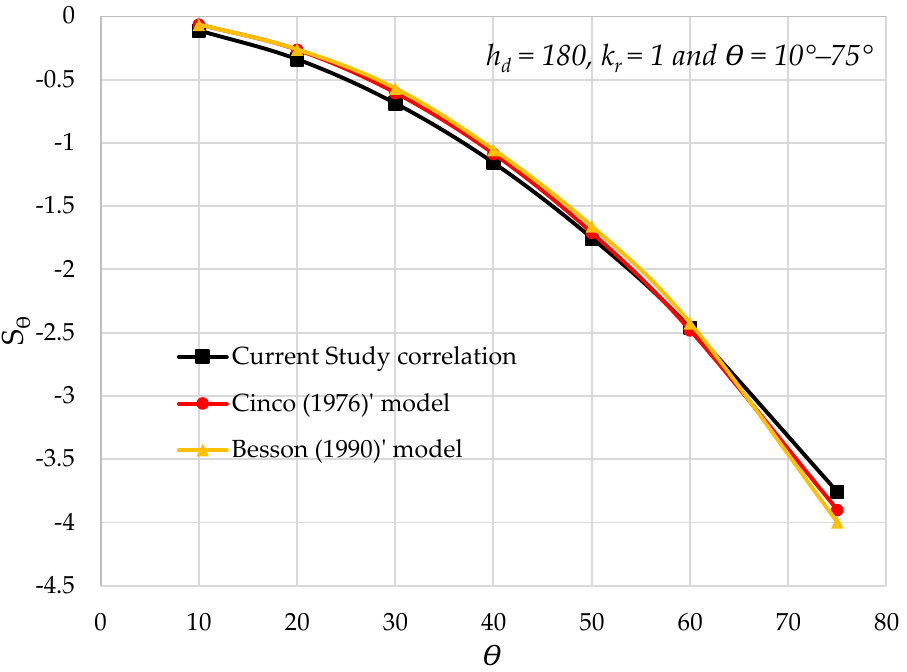
Figure 11. Comparison between the current correlation and the slant skin model results of Cinco et al. (1975) [1] and Besson (1990) [2] for increasing the angle of the slant (10 ◦ –75 ◦